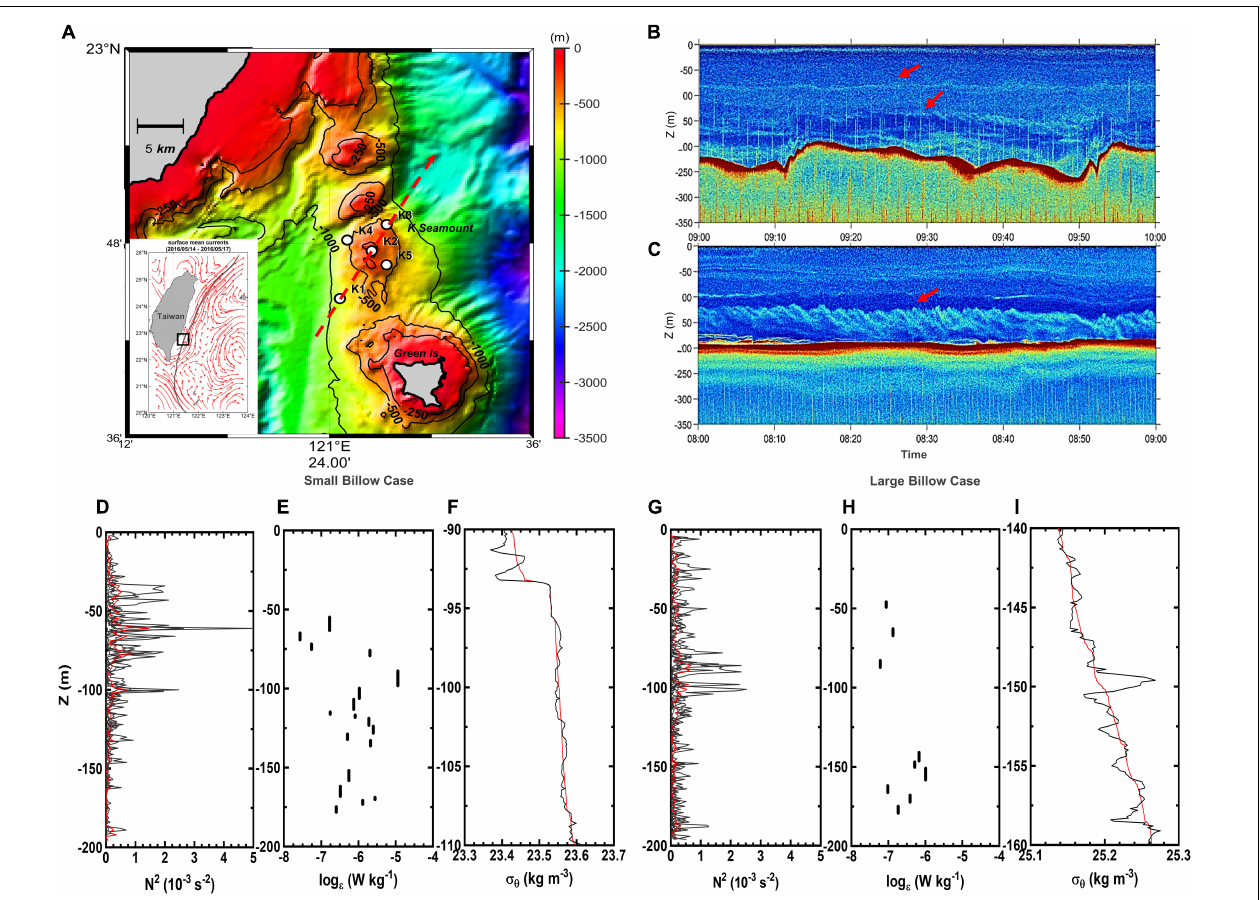
FIGURE 1 | The K seamount located north of Green Island off the southeastern coast of Taiwan (A) . The bathymetry shows isobaths (black contour lines) at –250, –500, and –1000 m depths. The white circles indicate the locations of the sampling stations on and around the K seamount. The red, dashed line is an along-stream transect indicating the direction and estimated location of the Kuroshio core. Examples of echosounder images (1-h duration) on K2 station during (B) small billow case (SBC; 2016) and (C) large billow case (LBC; 2018) show trains of billows (red arrows). The averaged values of the buoyancy frequency ( N 2 ; red curves) were computed from the six CTD profiles measured on K2 station (black curves) during SBC (D) and LBC (G) . The water column profile matching the echo sounder images (B,C) showed active vertical overturning (E,H) with variable turbulent kinetic energy (TKE) dissipation rates ( ε ). The expanded observed [ ρ (z) ; black] and re-ordered [ ρ ( z ); red] density profiles (F,I) coincided with identified “well-mixed” patches (E,H) . Note the scale differences in x - and y -axes in (F,I)